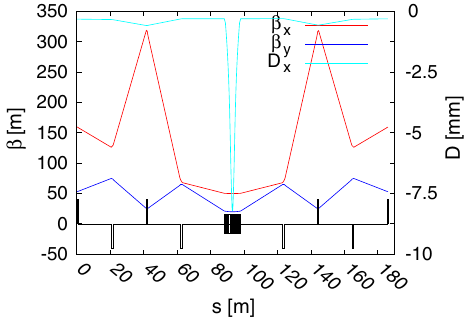
FIG. 4. Twiss and dispersion functions in the wiggler section with B þ ¼ 0 . 7 T. The Twiss functions are practically unchanged; j (and orbit deviation) is 8 mm. the peak j D x